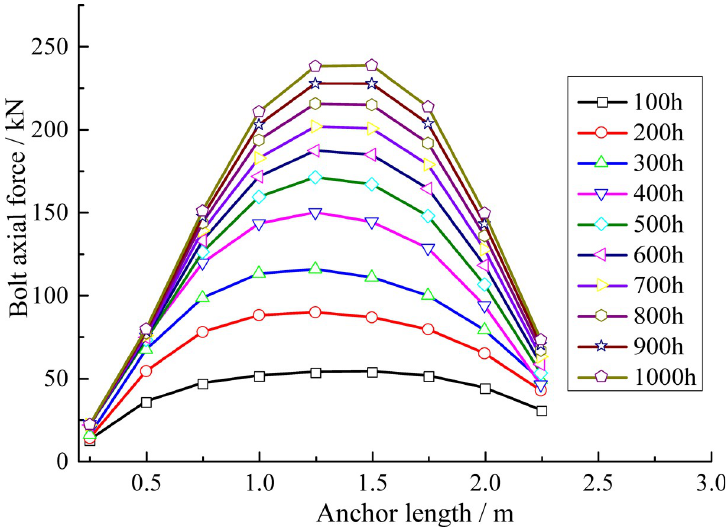
Fig 18. Anchor rod axial force as a function of